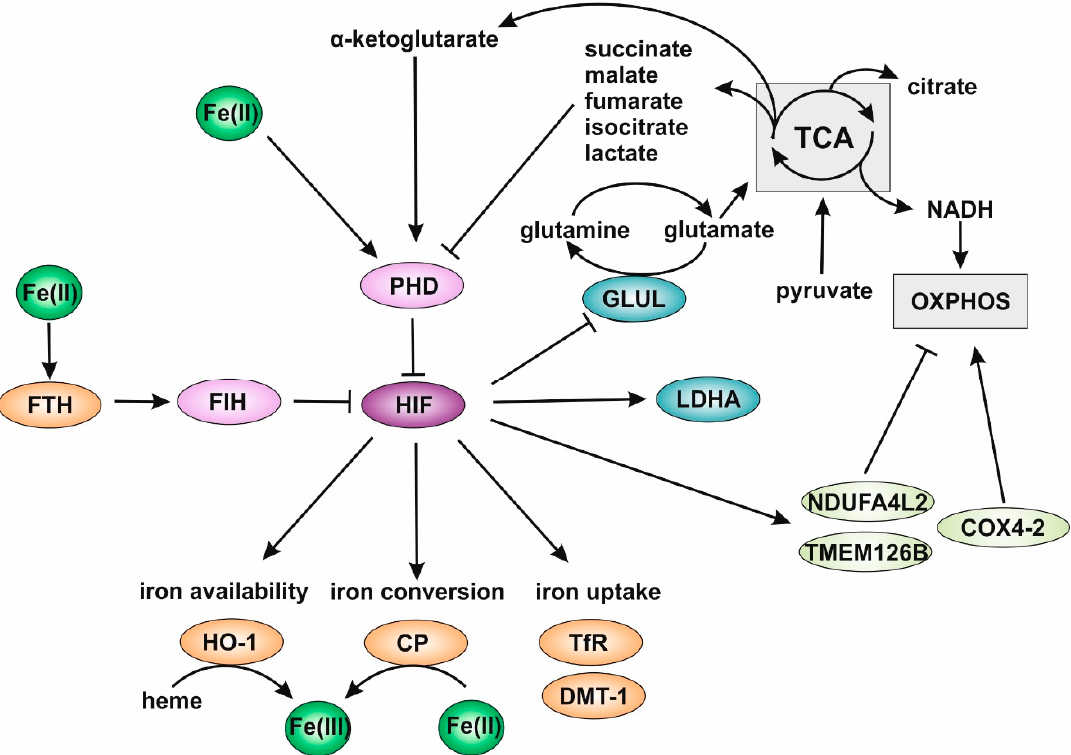
Figure 1. Hypoxia inducible factor (HIF) as a central mediator in iron homeostasis. Degradation of hypoxia inducible factors (HIFs) is mediated by prolyl hydroxylases (PHDs), which are regulated